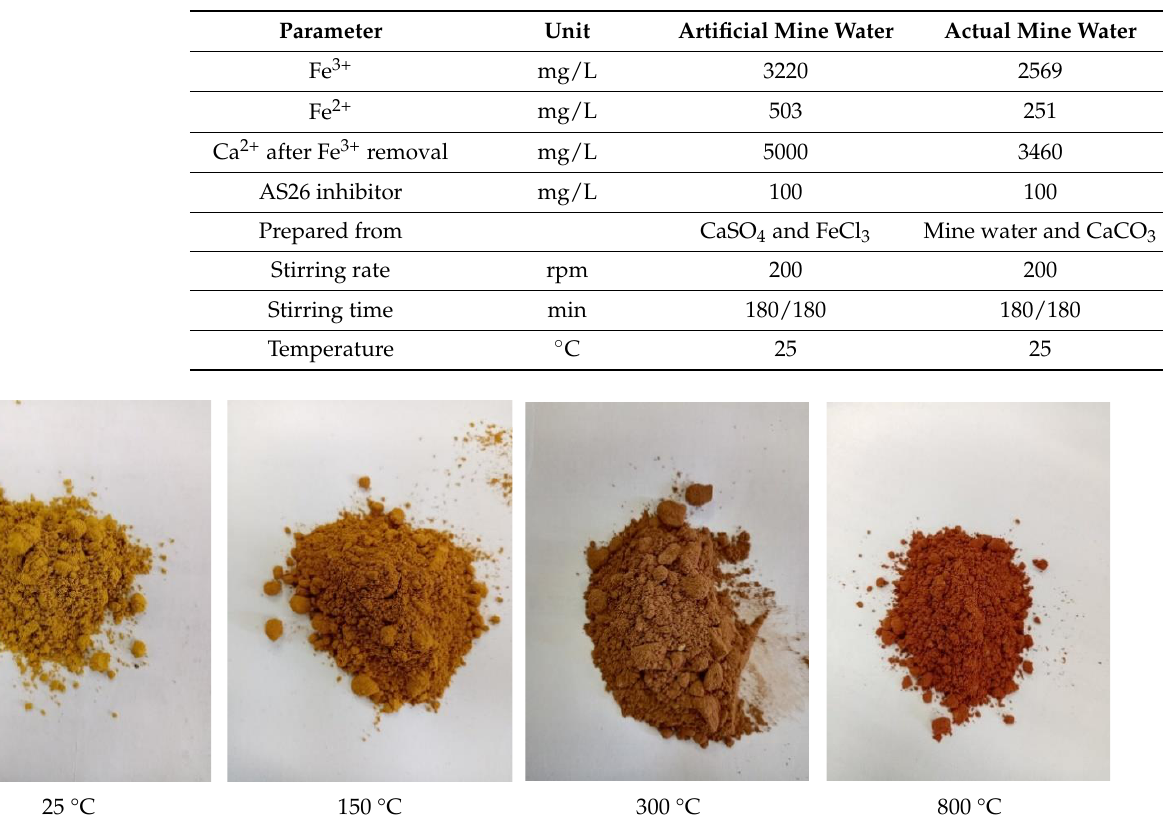
Figure 13. Pigments produced from iron-rich mine water using CaCO 3 for neutralization.